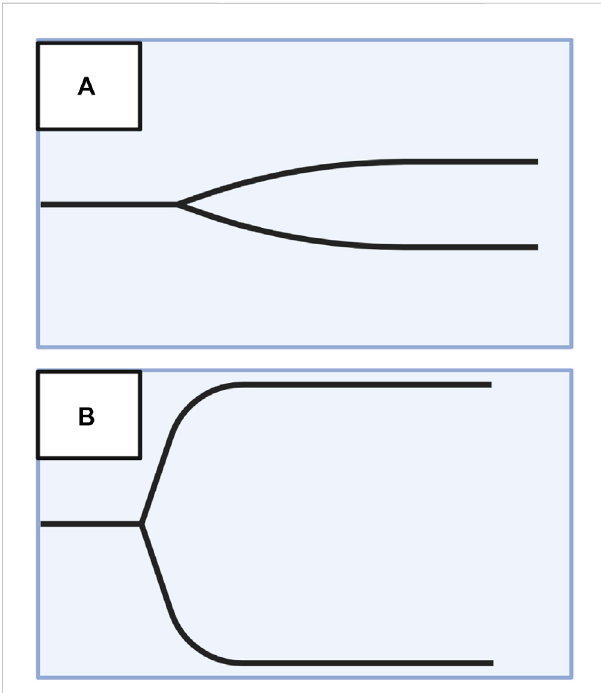
FIGURE 12 Thromboelastography (TEG) Tracings Before and After Administration of Antivenom and Blood Products. Tracing (A) demonstrates venom-induced consumption coagulopathy (VICC) with low α -angle and reduced maximum amplitude of a patient who required multiple rounds of antivenom to achieve hemostatic competence. Tracing (B) demonstrates successful treatment with resolution of VICC. In total, this patient received 24 rounds of antivenom, two units of packed red blood cells, and two units of cryoprecipitate (Leffers et al., 2018). Created with